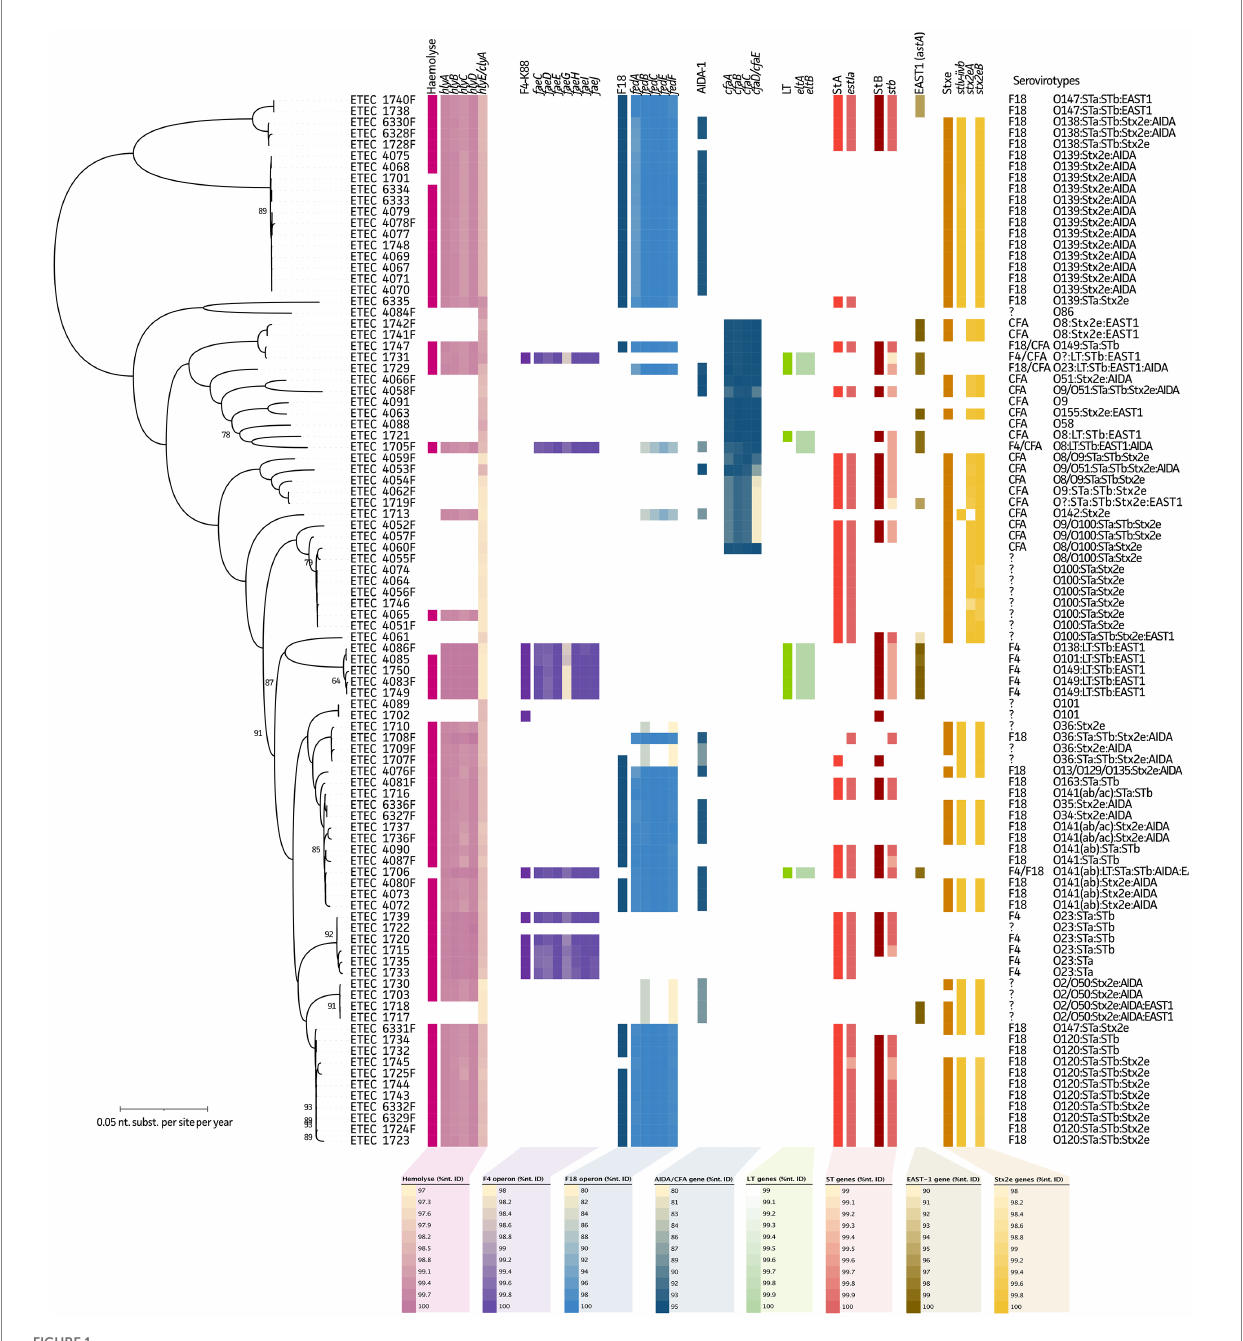
FIGURE 1 Maximum Likelihood (ML) tree of 94 ETEC/STEC strains in relation to their serovirotypes. Phylogenetic tree highlights the diversity of the studied ETEC/ STEC strains and the presence of fimbrial and virulence genes. From left to right in the tree: hemolysis (as observed from blood agar plates), hly(A-E) genes, F4 fimbriae (multiplex PCR), fae(C-J) genes, F18 fimbriae (multiplex PCR), fed(A-F) genes, non-fimbrial AIDA gene, LT (multiplex PCR), eltA/eltB genes, STa (multiplex PCR), estIa gene, STb (multiplex PCR), stb gene, astA gene, Stx2e (multiplex PCR), and Stx2eA/Stx2eB genes. Note, two different Stx2eA variants were identified. Complete serovirotypes are given at the utmost right and legends represent nucleotide identity ranges of genes obtained from WGS